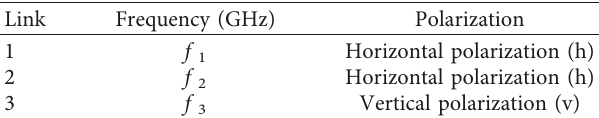
Figure 1: Energy of each microwave link is attenuated by rainfall and other factors between the microwave transmitter and receiver, and the attenuation is recorded in the data acquisition system. Thus, rain-induced attenuation of three links can be obtained with the help of extraction algorithm of the rain-induced attenuation. h and v represent horizontal and vertical polarizations, respectively. Table 2: Frequencies and polarizations of the microwave links.